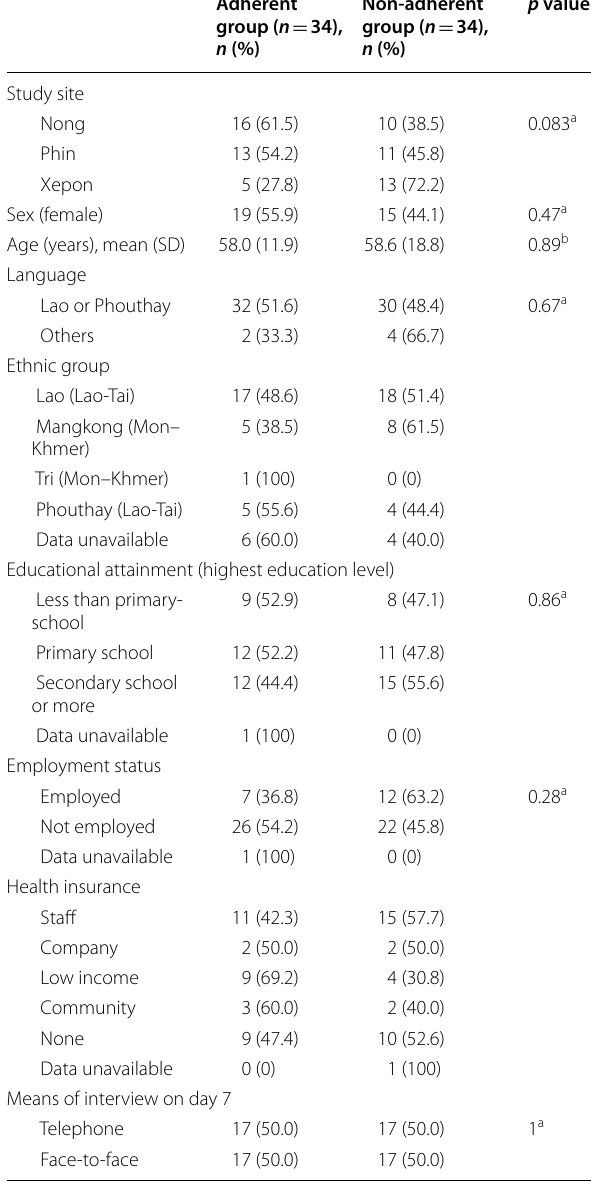
Table 2 Socio-economic characteristics of the